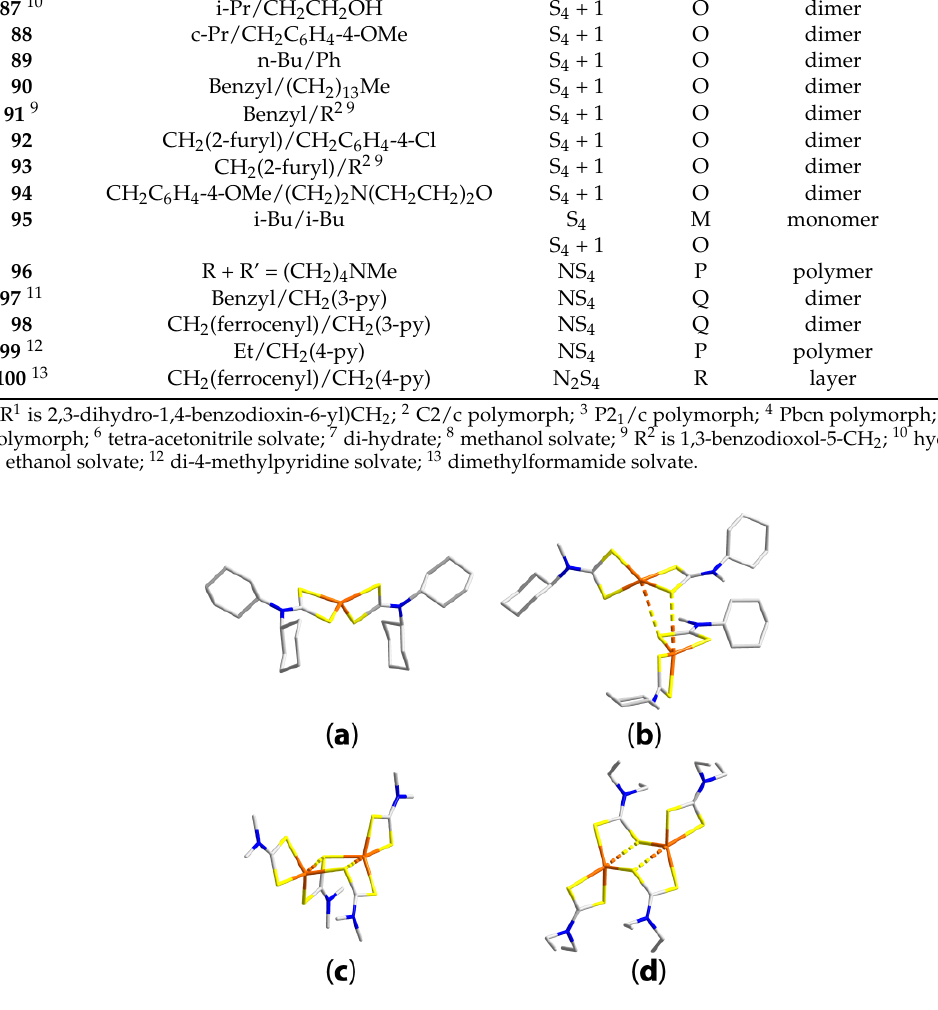
Figure 8. ( a ) Molecular structure of Zn(S 2 CNCy 2 ) 2 ( 37 ) where the the zinc atom lies on a 2-fold axis; ( b ) supramolecular association via Zn···S interactions (3.58 Å ) between two molecules disposed about a 2-fold axis of symmetry in the crystal of Zn[S 2 CN(Me)Cy] 2 ( 35 ); ( c ) molecular structure of {Zn(S 2 CNMe 2 ) 2 } 2 ( 49 ) where the molecule has 2-fold symmetry; and ( d ) molecular structure of {Zn(S 2 CNEt 2 ) 2 } 2 ( 53 ) where the molecule is disposed about a centre of inversion. The dashed bonds in ( c ) and ( d ) represent transannular Zn···S interactions.